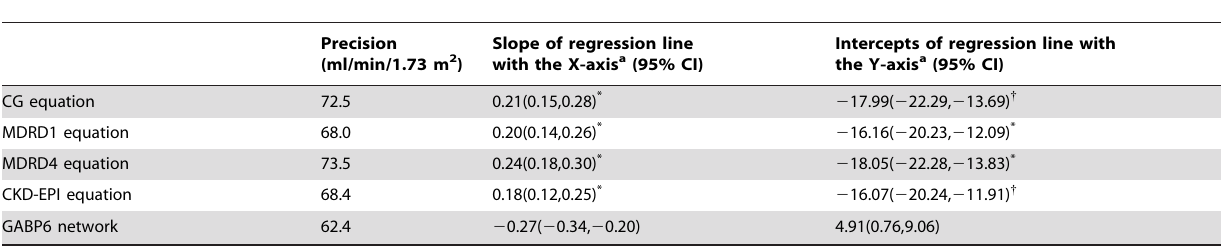
Table 5. Overall performance of agreement between eGFR and sGFR in the additional external validation data set.